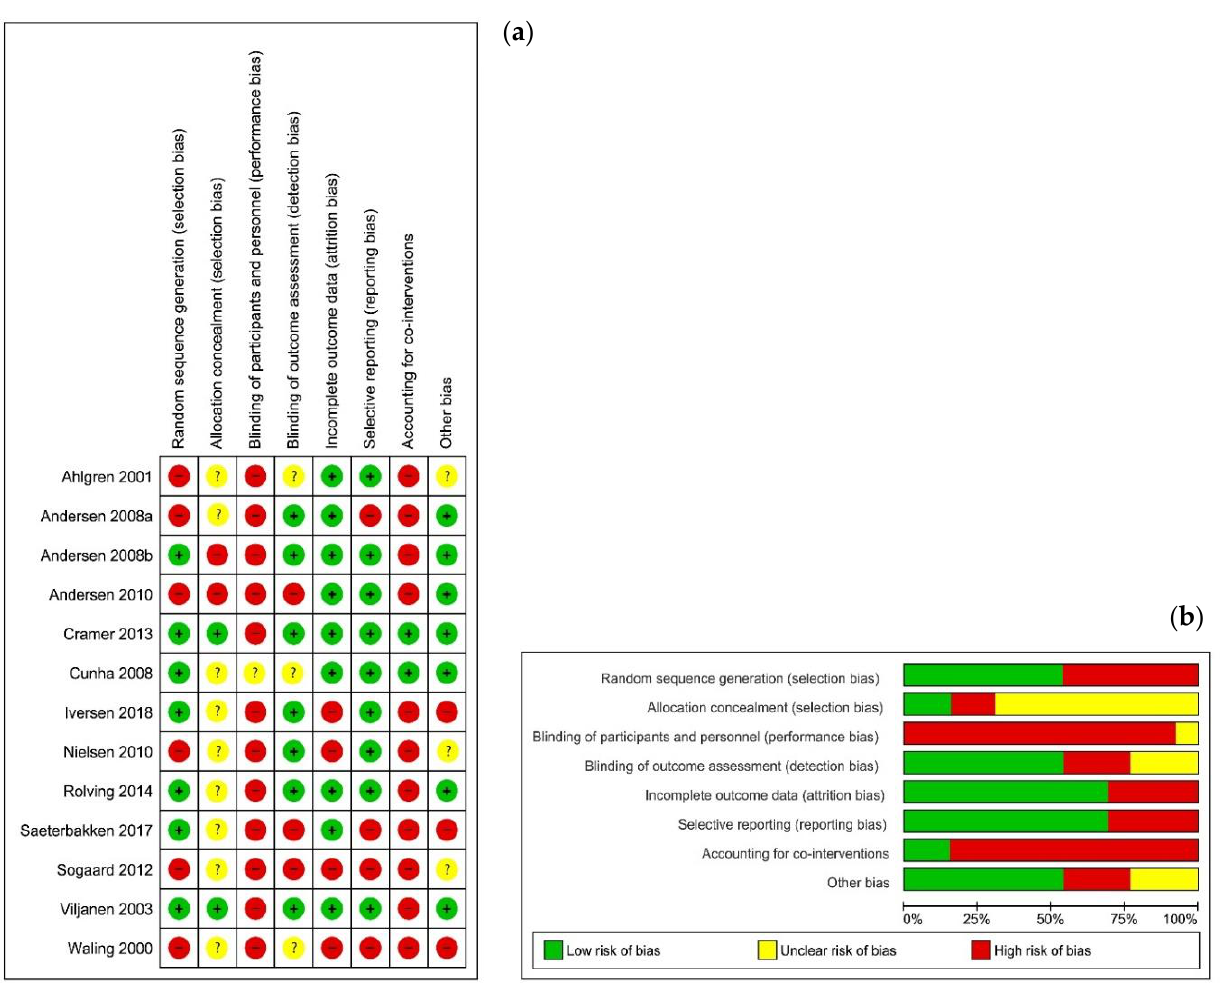
Figure 2. Risk of bias summary. These graphs illustrate the review authors’ judgements about each risk of bias item for each included study ( a ) and presented as percentages across all included studies ( b ). Review Manager (RevMan) 5.3. [34]. Legend: (+) indicates “low risk of bias”; (?) indicates “unclear risk of bias”; (−) indicates “high risk of bias”.